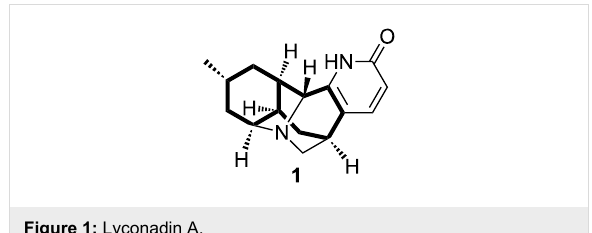
Figure 1: Lyconadin